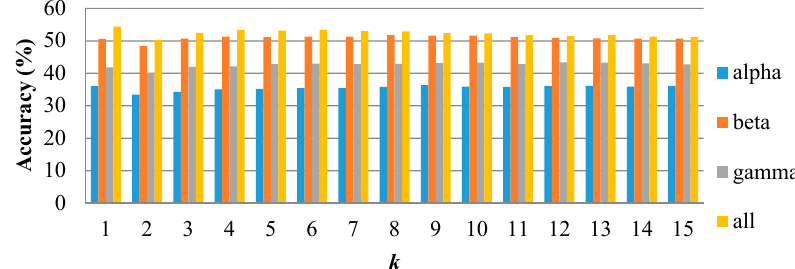
Figure 10. Average classification performance of bispectrum features by varying k values for the NC group using KNN.